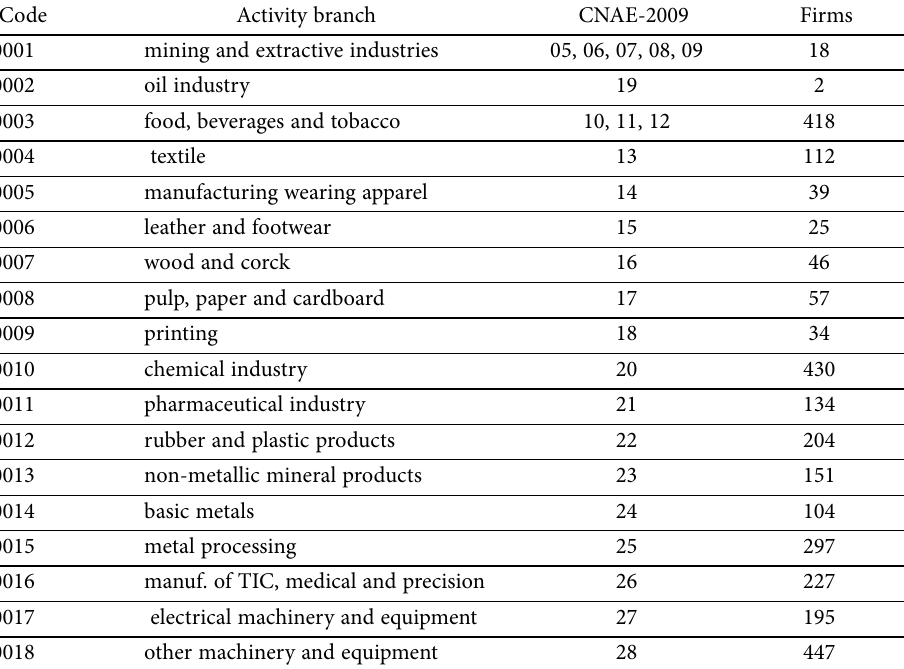
Table A1. Number of firms per activity branch in the